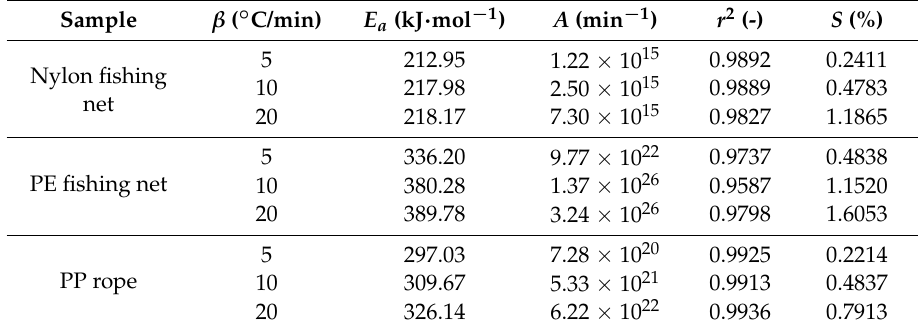
Table 4. Kinetic parameters of the plastic coastal debris samples in the pyrolysis process at different heating rates.